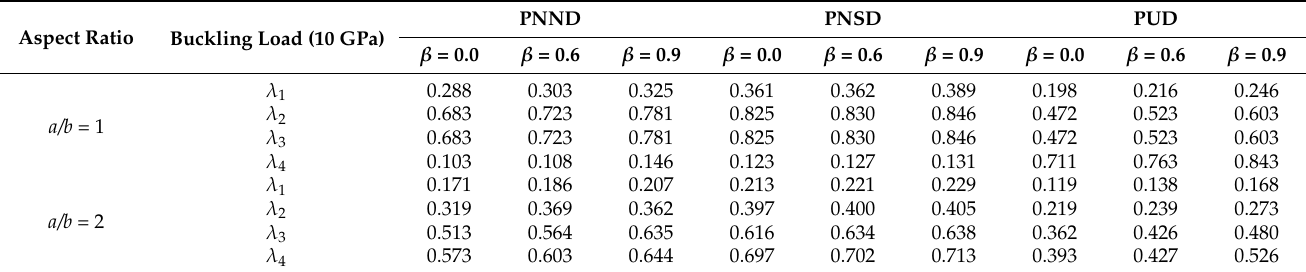
Table 10. First four biaxial buckling loads for a SSSS FG-saturated porous plate with different aspect ratios, a / b , porosity distributions and Skempton coefficients, β , while keeping e 0 = 0.6